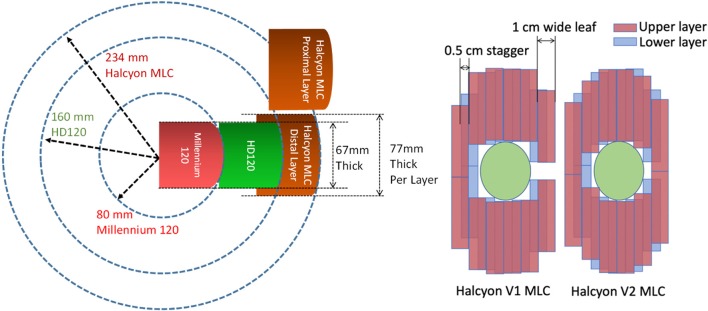
(Left) MLC Design comparison of current dual-layer Halcyon MLC (brown) vs. 0.25 cm wide HD-120 MLC (Green) and 0.5 cm wide Millenium-120 MLC (Red) showing increased leaf thickness and rounding radius. (Right) Different between Halcyon MLC version 1 and version 2. Halcyon V2 enables the upper layer to be used for beam shaping, effectively producing 0.5 cm modulation resolution.